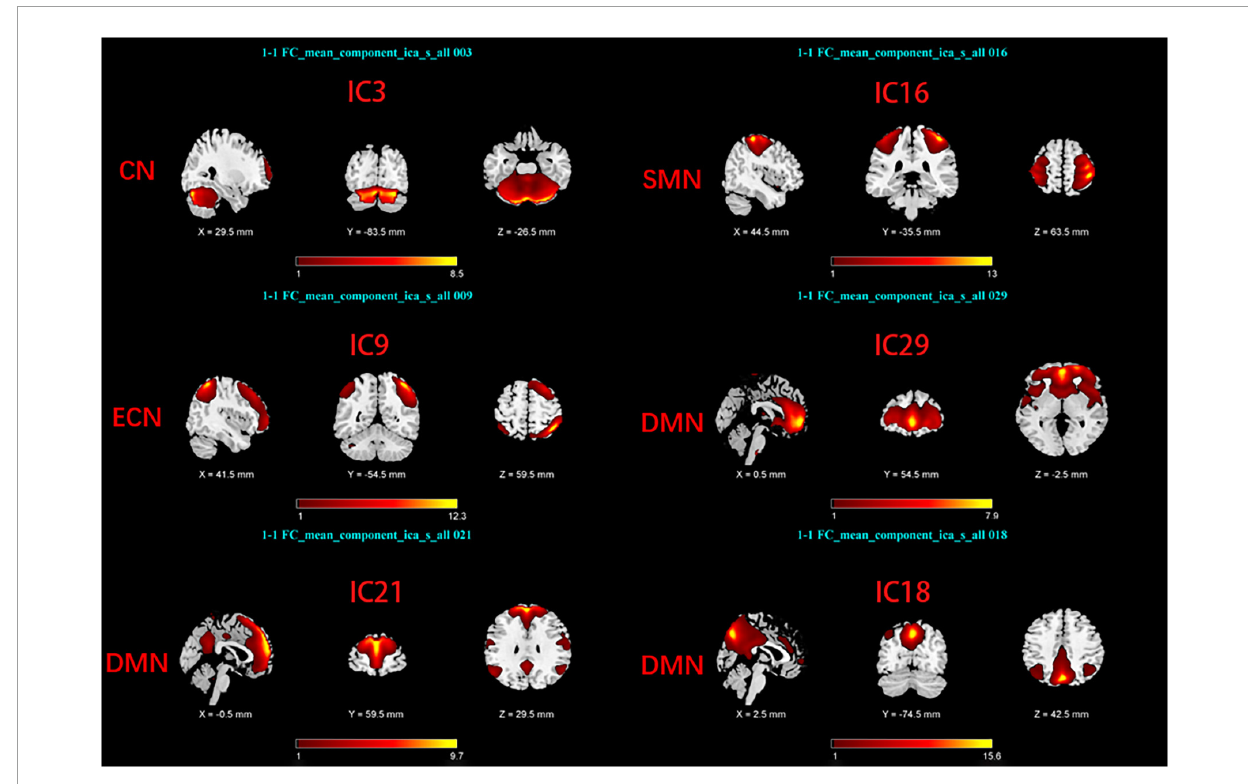
FIGURE1 Spatial maps of brain networks of EOPD and YCs. SMN, sensorimotor network; DMN, default mode network; ECN, executive control network; CN, cerebellar